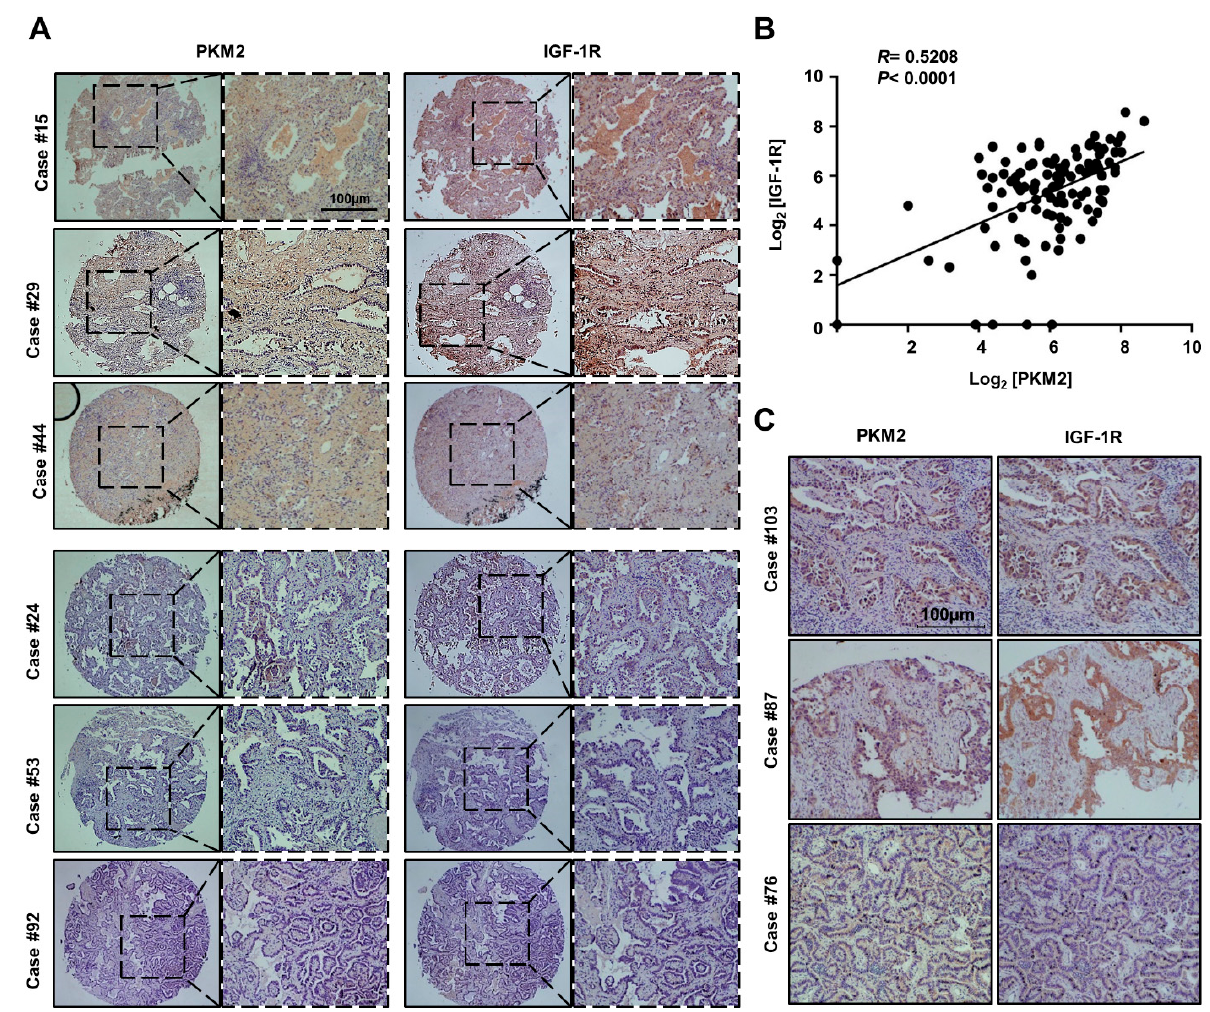
Figure 5. PKM2 expression positively correlates with IGF-1R expression in human lung adenocarcinoma tissues. ( A ) Representative immunohistochemistry (IHC) images of lung cancer tissue microarrays (TMA) using specific antibodies. ( B ) The correlation between IGF-1R and PKM2 protein in lung cancer patient tissues. ( C ) Representative images showing co-localization of PKM2 and IGF-1R expression among the IHC images of the lung cancer TMA.